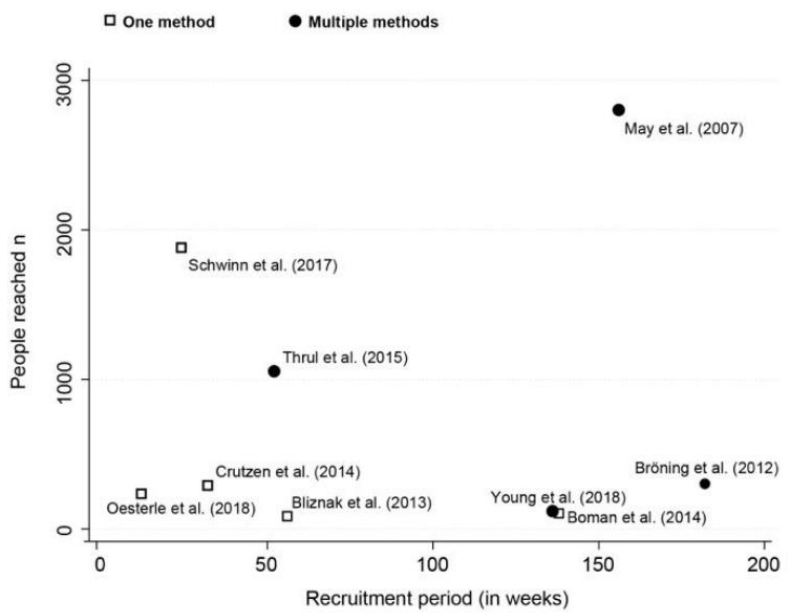
Figure 2. Scatterplot of available studies (n = 9) for recruitment period in weeks and number of people reached (i.e., with whom a first contact was made). Separated according to study recruitment methods [23,24,26,28 – 31,33,35].